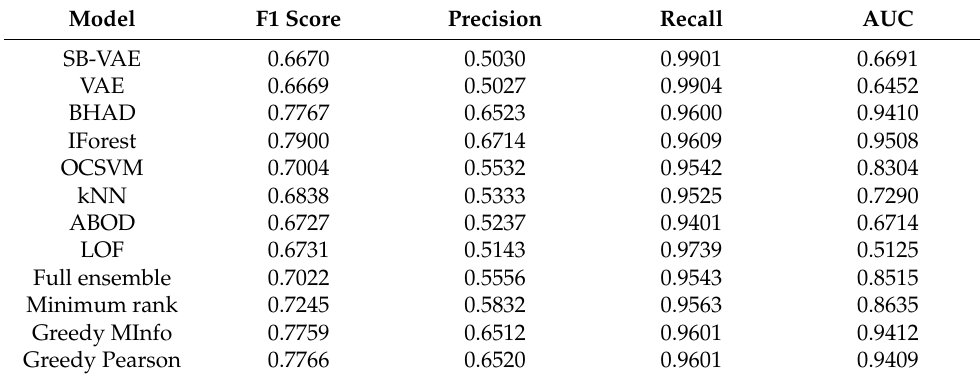
Table 2. Results: Pendigits dataset.